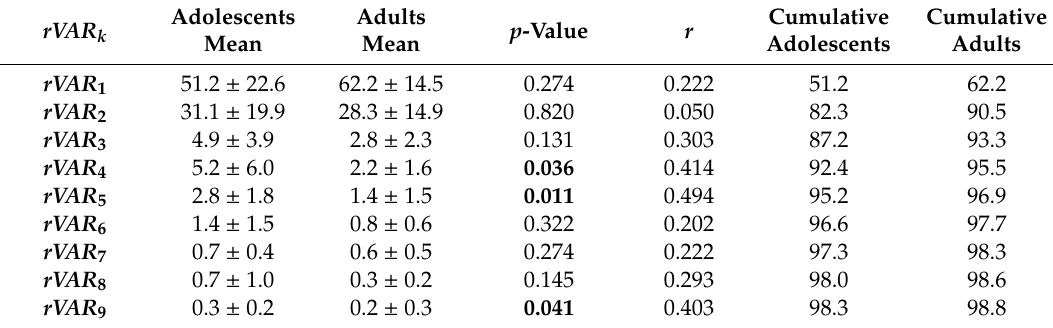
Table 2. rVAR k of adolescents and adults in the di ff erent movement components during the eyes-open trial. Means ± SD of each group are presented, bold p -values present p -values < 0.05, which did not meet the threshold of significance after correction. E ff ect sizes ( r ) are displayed according to Rosenthal.